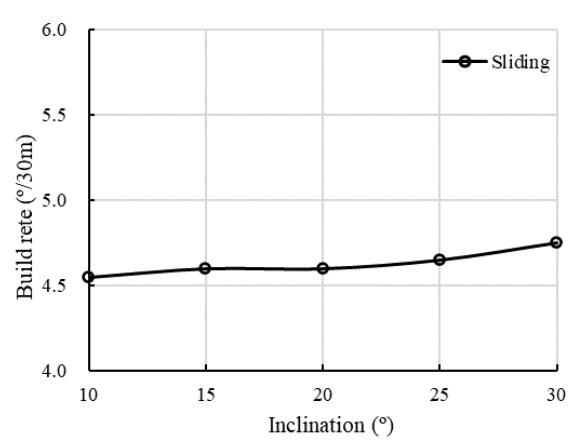
Fig. 13. Rotating build rate VS WOB for BH-PDM-S BHA